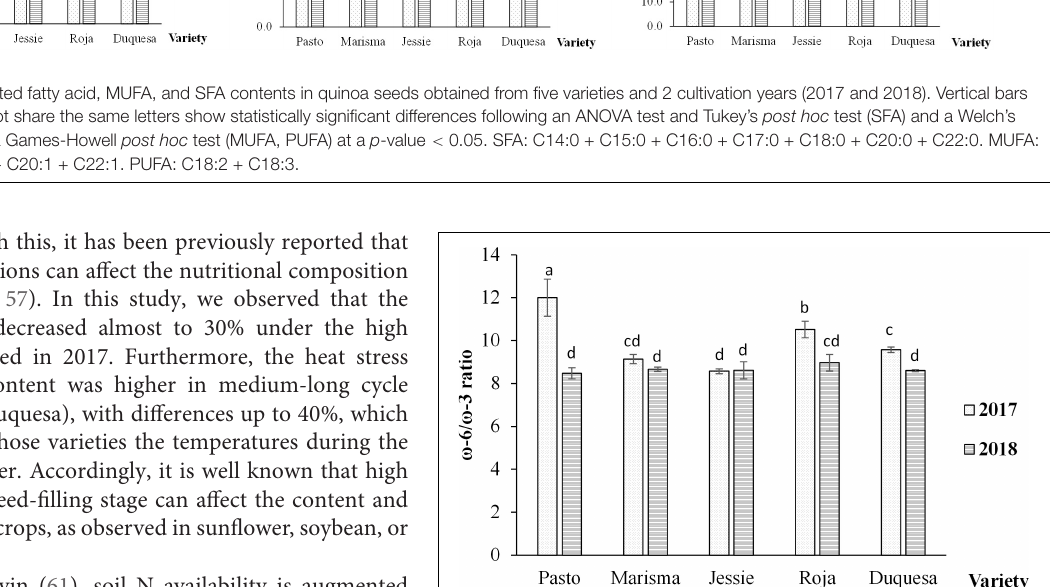
FIGURE 7 | Ratio of omega-6 ( ω -6) to omega-3 ( ω -3) essential fatty acid (EFA) contents in quinoa seeds obtained from five varieties and 2 cultivation years (2017 and 2018). Error bars correspond to the SDs. Bars that do not share the same letters show statistically significant differences following an ANOVA test and Tukey’s post hoc test at a p -value < 0.05. Total ( ω -3): α -linolenic—C18:3. Total ( ω -6): linoleic